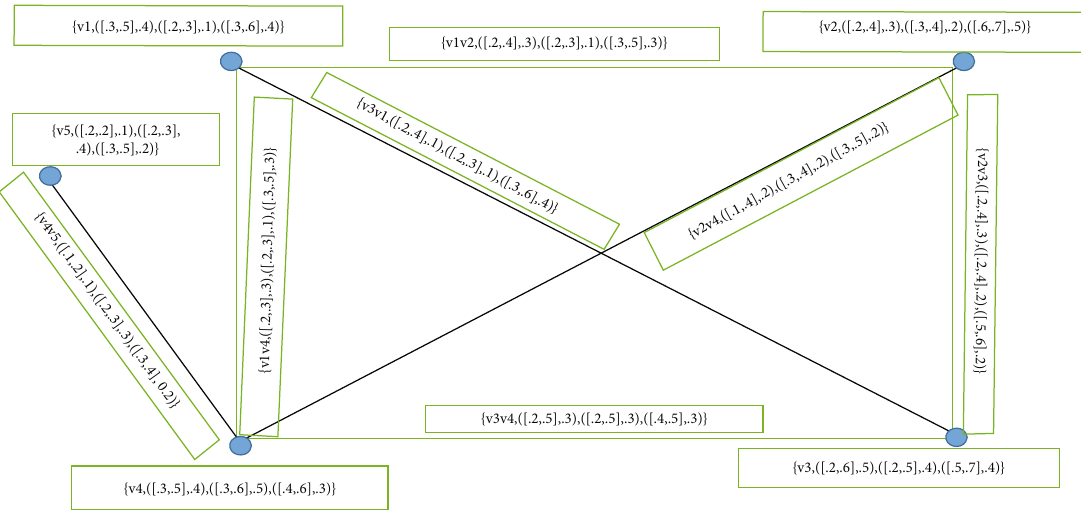
Figure 6: Represents totally irregular neutrosophic cubic